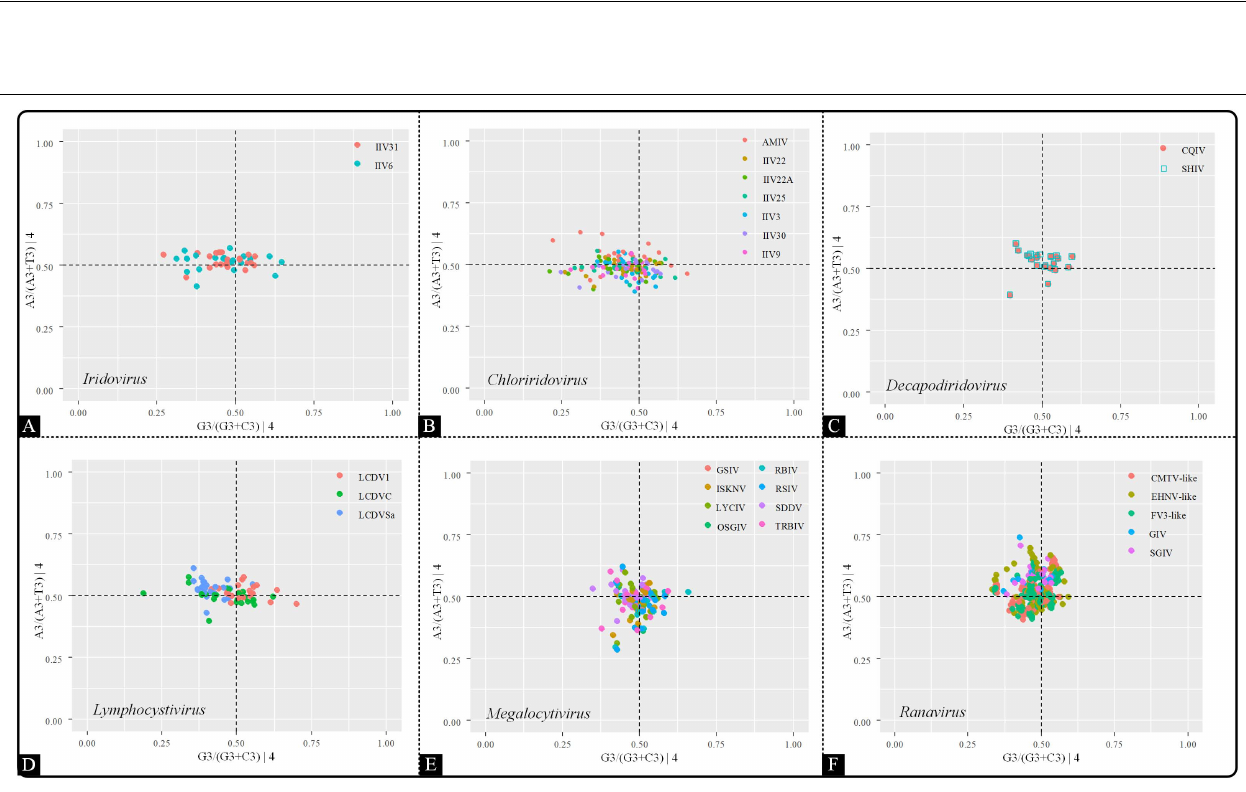
Frontiers in Microbiology |